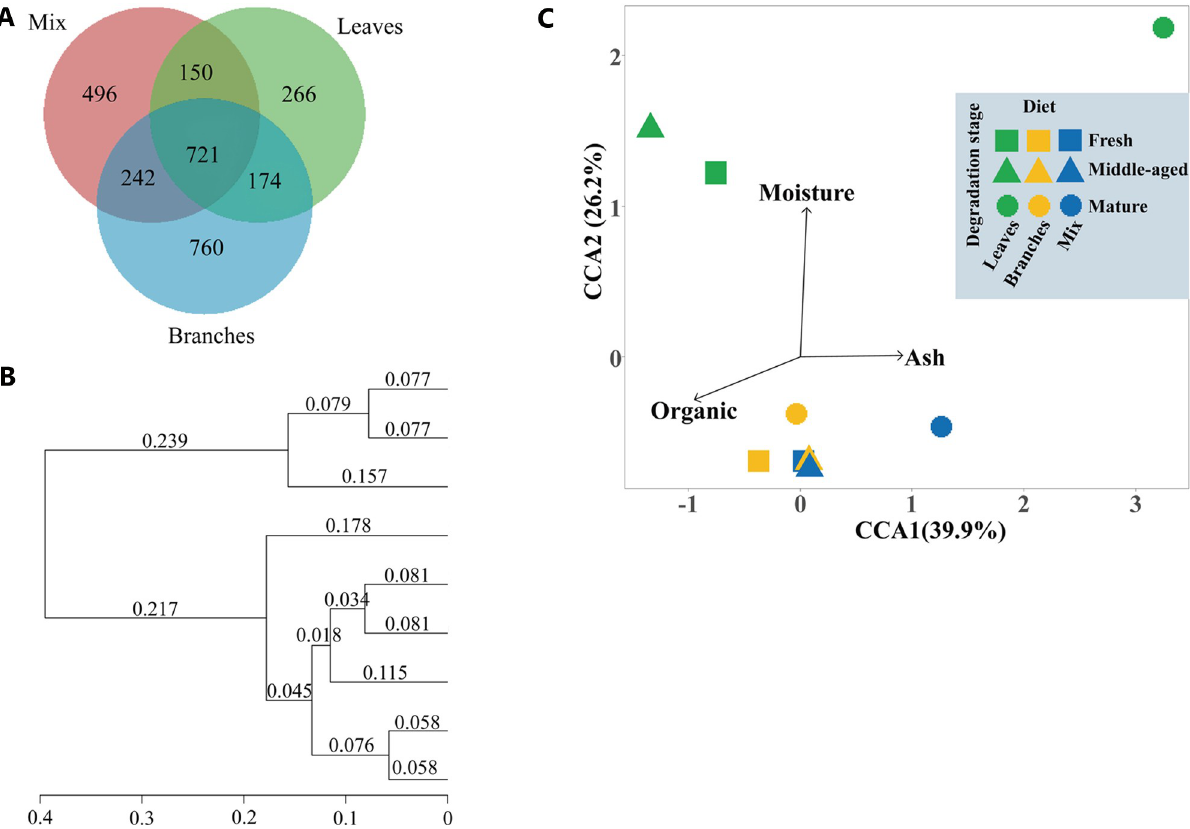
Fig 3. Bacterial community profiles at different decomposition stages of fungus-combs. (A) Common bacteria OTU Venn diagram of fungus- combs built from different foods (OTUs whose abundance lower than 0.001% of total sequences were removed). (B) Community similarities based on weighted Unifrac metric; (C) The constrained corresponding analysis (CCA) of the bacterial community and variation partition analysis for three physicochemical indexes. Whereas TL, ML, BL, TB, MB, BB, TM, MM, and BM described in Table 1. The Denoising stats of OTUs are listed in S6 Table.